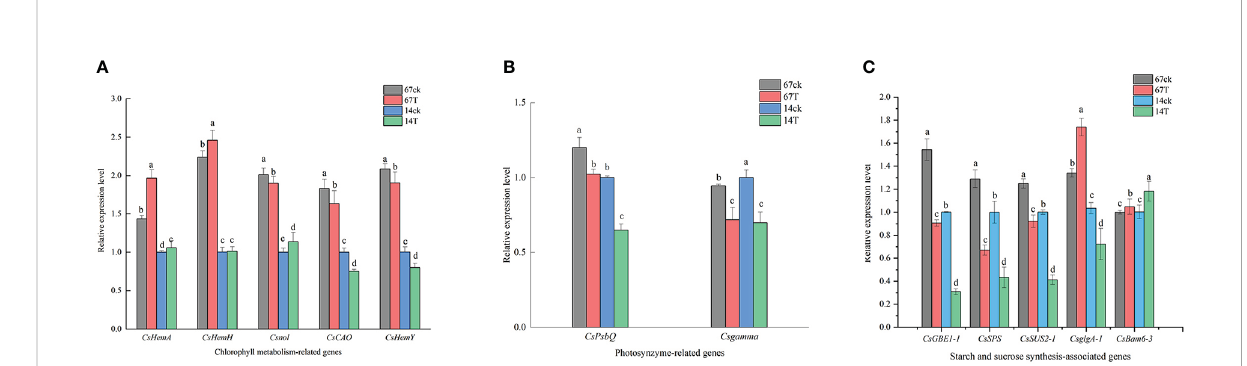
FIGURE 10 (A) The relative expression level of Chlorophyll metabolism-related genes. Lowercase letters a and b after the value represent statistically signi fi cant differences (p < 0.05) within a variety under different low-light treatments as determined by the least signi fi cant difference test. (B) The relative expression level of photosynthesis-related genes. Lowercase letters a and b after the value represent statistically signi fi cant differences (p < 0.05) within a variety under different low-light treatments as determined by the least signi fi cant difference test. (C) The relative expression level of starch and sucrose synthesis-related genes. Lowercase letters a and b after the value represent statistically signi fi cant differences (p < 0.05) within a variety under different low-light treatments as determined by the least signi fi cant difference